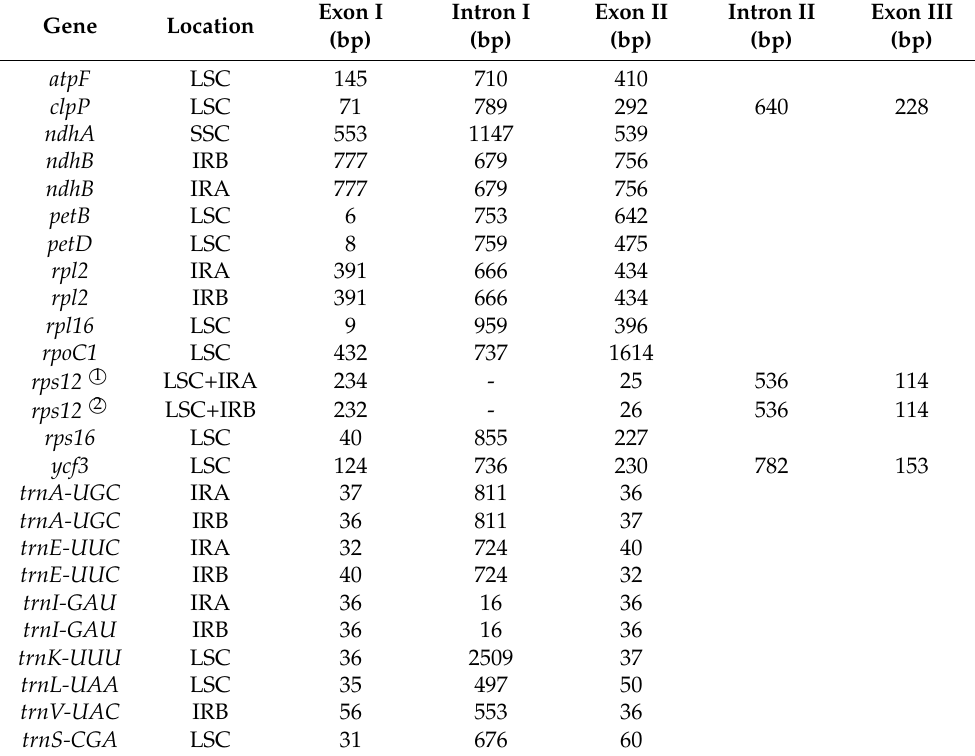
Table 3. Genes with intron in the P. angulata var. villosa plastome and length of exons and intron. Exon I Gene Location